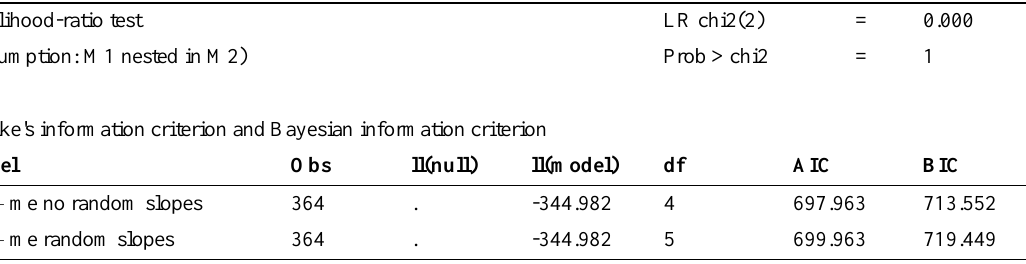
Table 6: LR test on the effect of assurance as level-2 random covariate